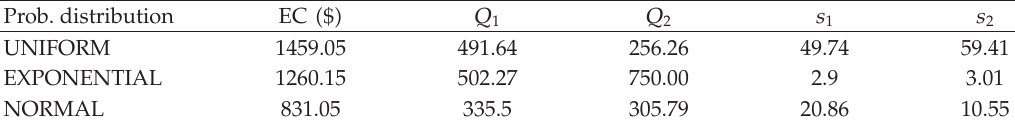
Table 4: Expected Annual costs of di ff erent stochastic